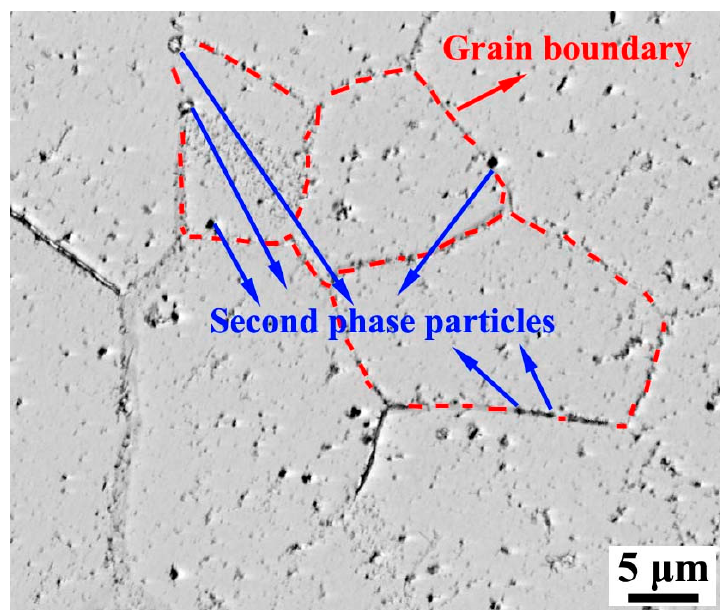
Figure 6. Second phase particle exist around the grain boundary of primary recrystallized steel with 0.009 wt% Nb.